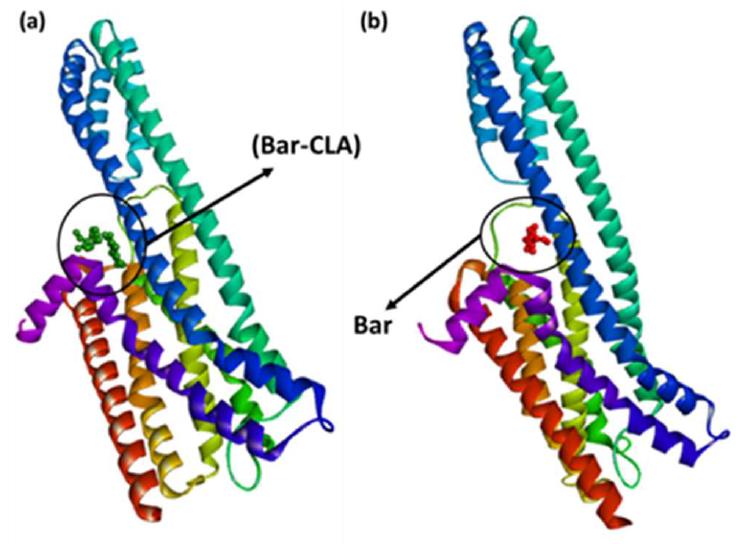
Figure 3. Serotonin (PDB ID: 6BQH) helical model in the best docking position with ( a ) (Bar–CLA) complex or ( b ) Bar alone. Table 3. The interaction data between (Bar–CLA) or Bar and serotonin (6BQH).